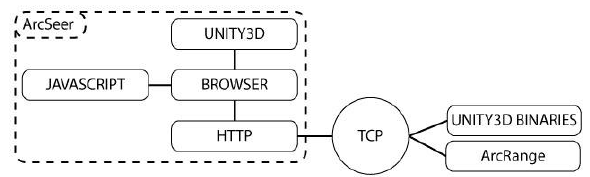
Figure 6: The ArcSeer/ArcRange data network